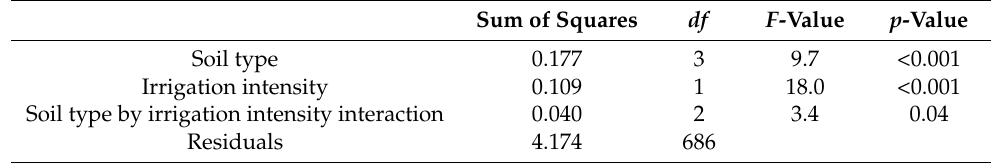
Table 2. The ANOVA (type II tests) table of the total relative increment of the studied third-year seedlings of Norway spruce according to soil type and irrigation